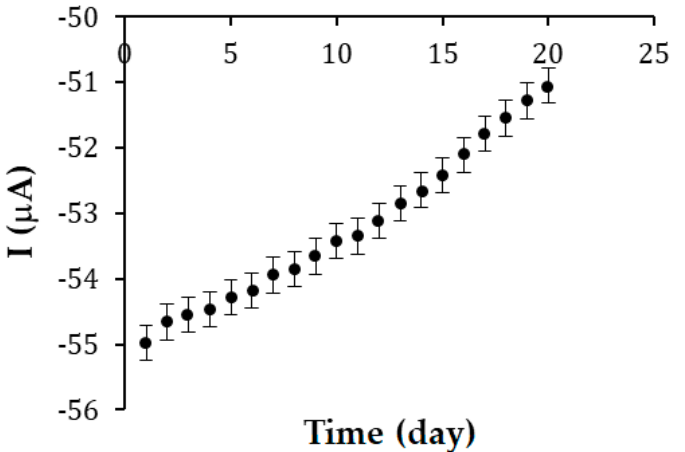
Figure 9. Cathodic current intensity obtained by immersing the same SPE/SWCNT/Tyr biosensor in a solution of 10 − 4 M OLEU, pH 7.0 over 20 consecutive days. The results are acceptable, considering that enzyme activity can easily degrade.